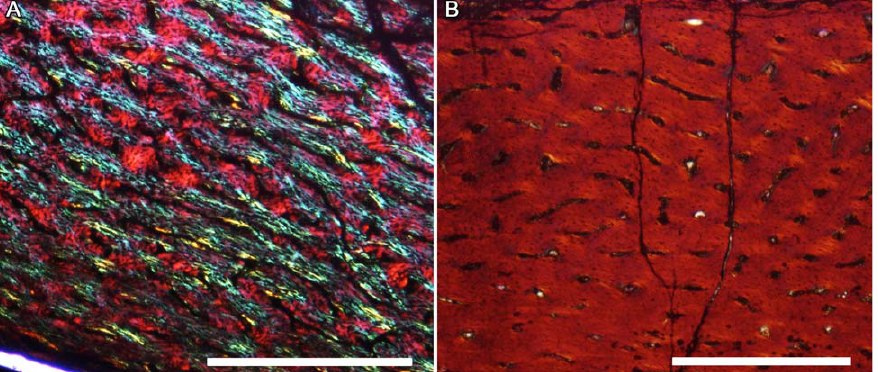
Figure 3. Theropod osteohistology. Diaphyseal sections of high-latitude and lower-latitude theropods. Scale bars, 500 m m. A) Theropod femur diaphyseal section from Victoria (NMV 186323). Note the well-vascularized cortex consisting of rapidly deposited tissue. B) Troodon tibia (MOR 563) from Montana, USA, showing a similarly well-vascularized cortex and rapidly deposited tissue.